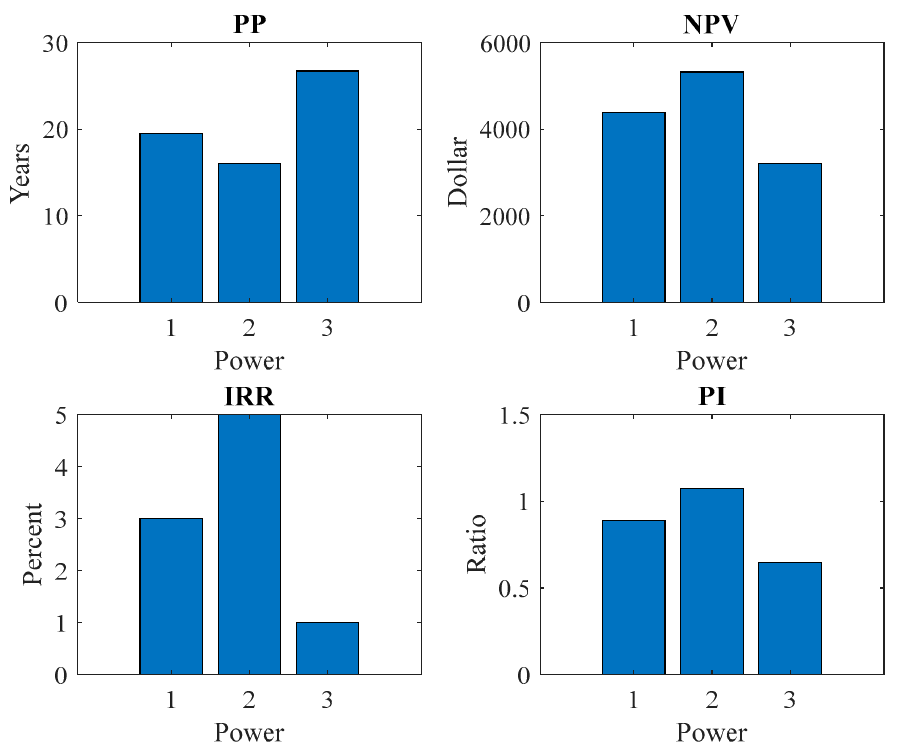
Figure 10. Economic parameters of building 3 in the state A.